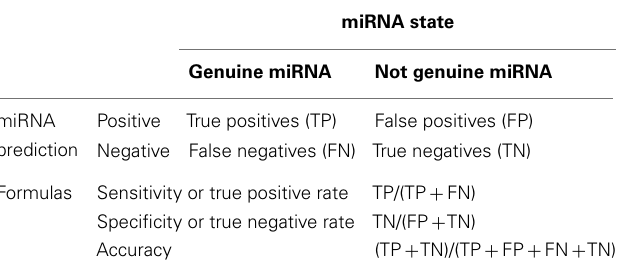
Table 3 | Sensitivity, specificity, and accuracy